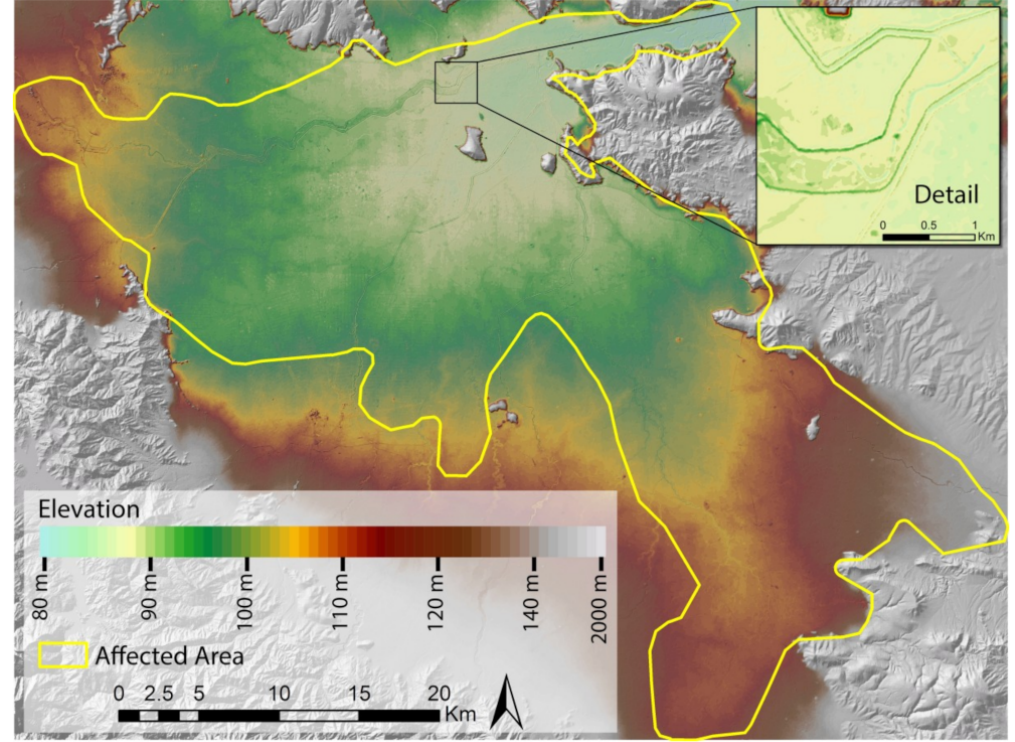
Figure 5. Detailed DEM of the affected area with 5 m spatial